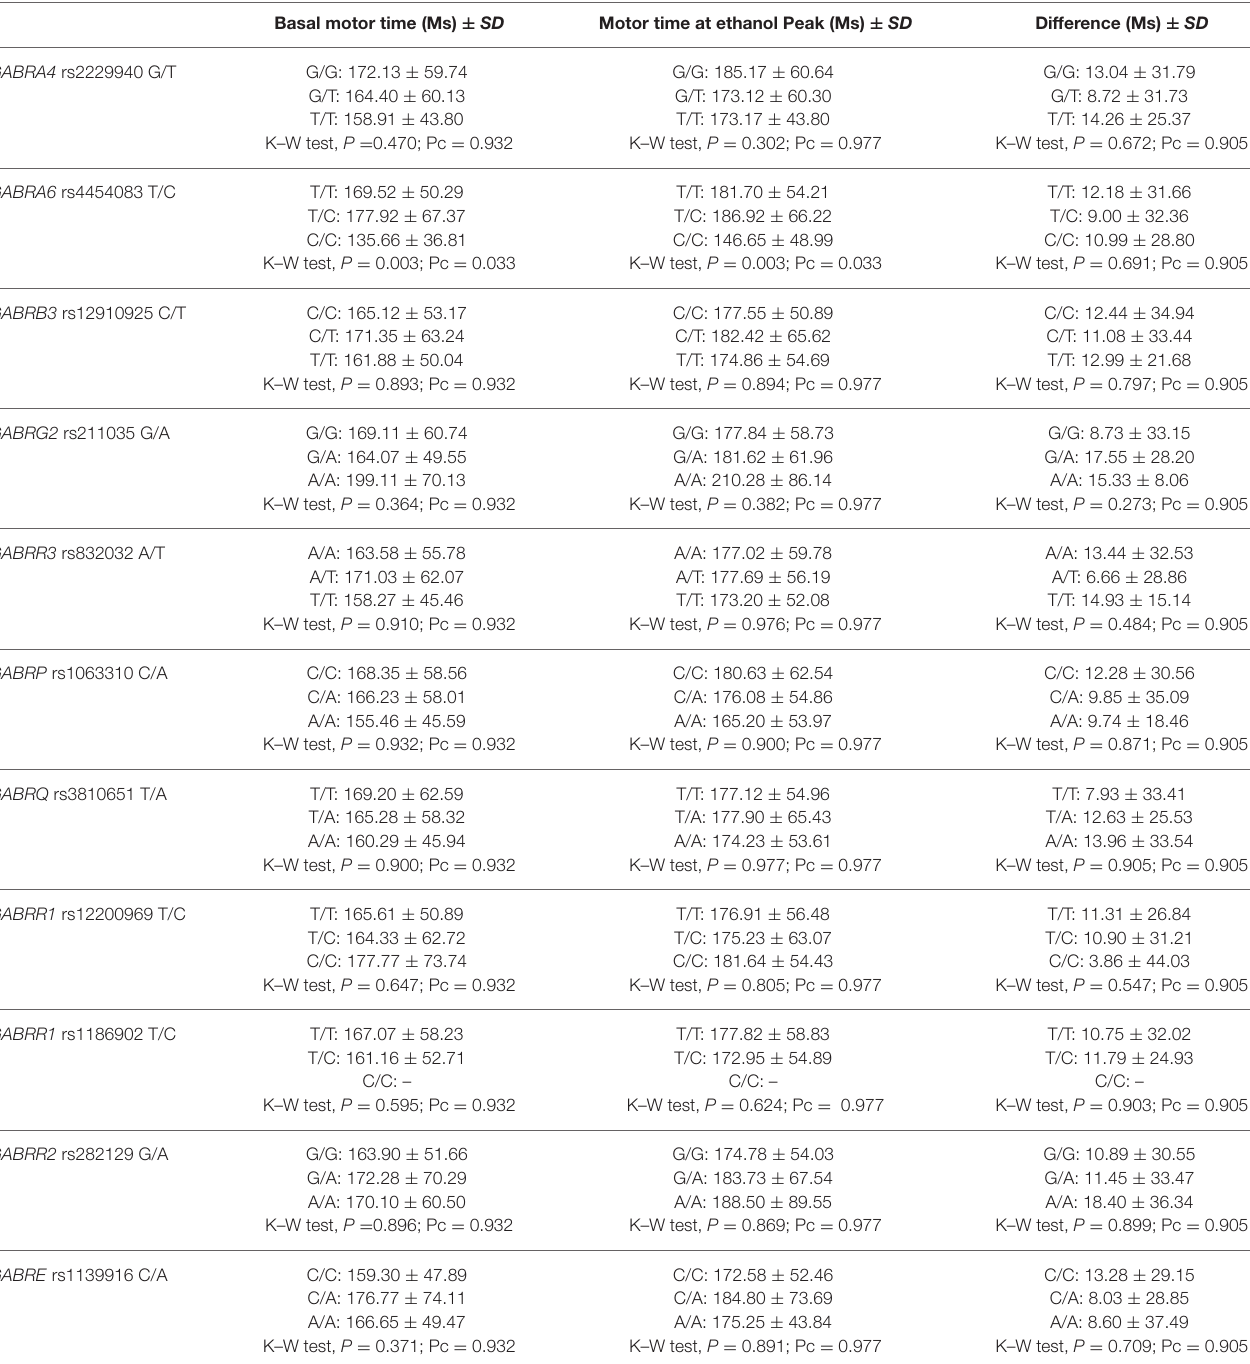
TABLE 4 | Distribution of motor times according GABR genotypes. Basal motor time (Ms) ±